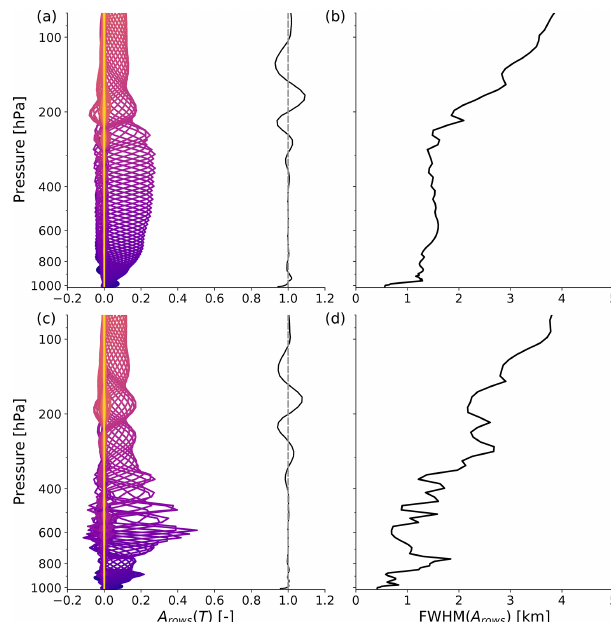
Figure A1. Same as Fig. 5 but for